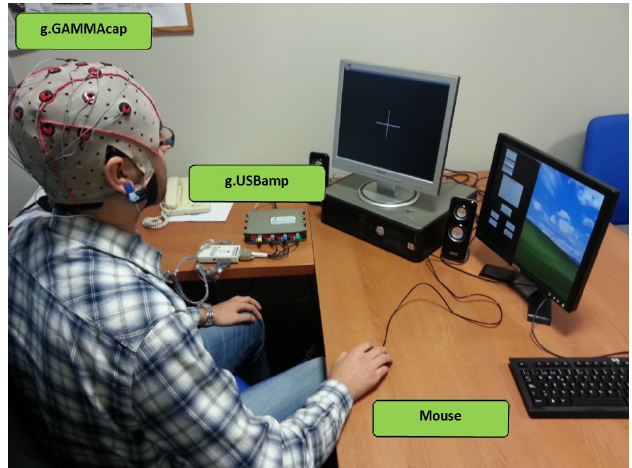
Figure 2. Experimental set up. The subject was wearing a cap with 16 electrodes and he/she had to move the mouse forward/backward. EEG signals were collected and registered by the